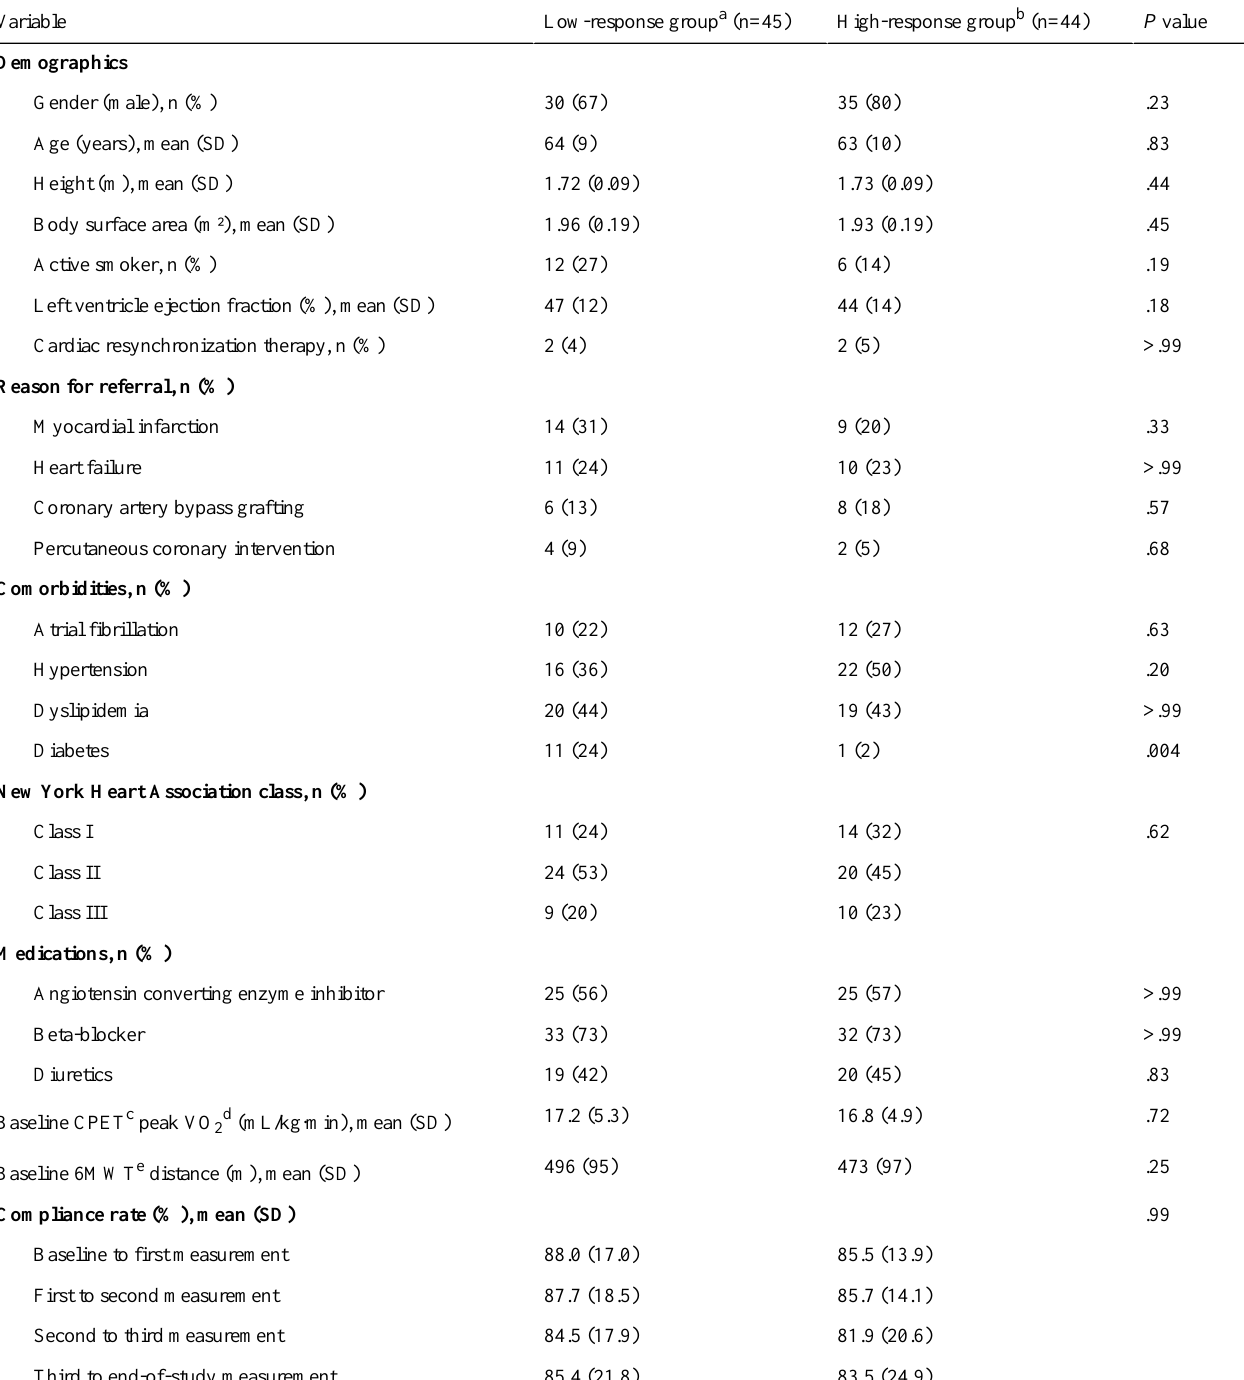
Table 1. Baseline